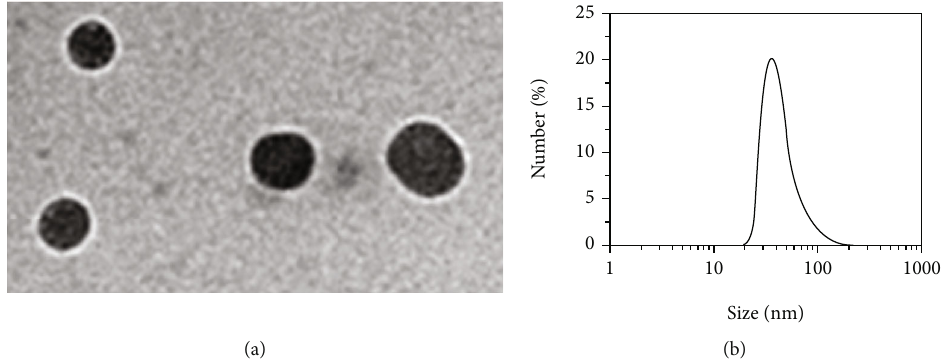
Figure 1: (a) Transmission electron microscopy image of NP-PEG-PEDF. (b) Size distribution of